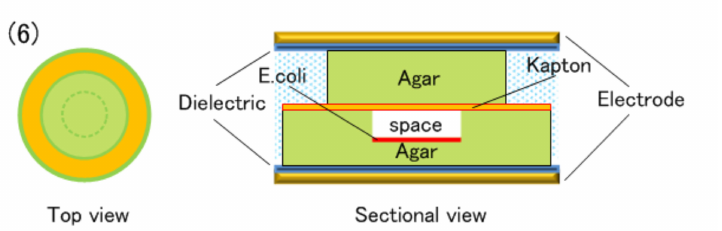
Figure 15. Agar medium configuration (6) with the polyimide film and positions of E. coli .